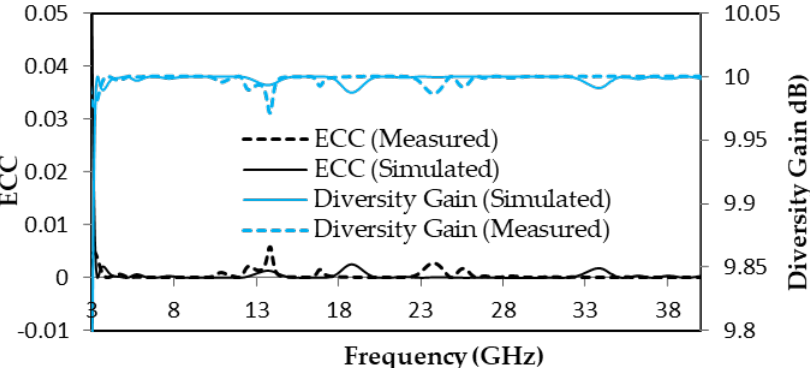
Figure 9. ECC and diversity gain of proposed antenna.